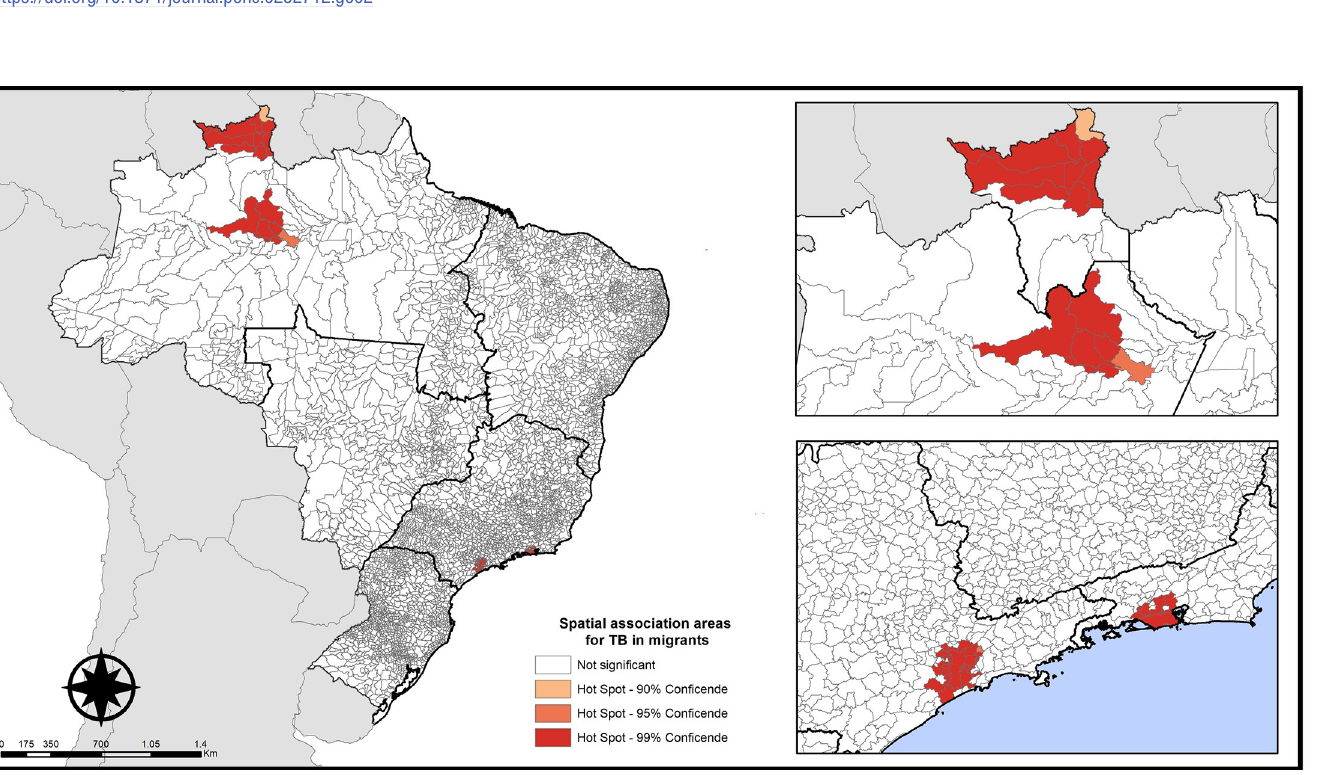
Fig 3. Spatial association areas for tuberculosis in migrants, Brazil (2014–2019). Source: prepared by the authors.